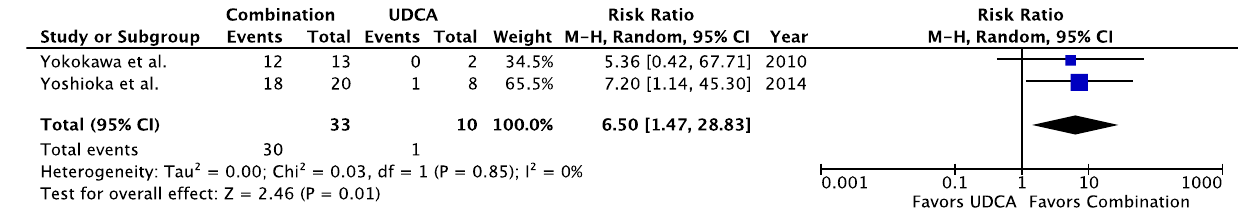
Figure A5. Transplant-free survival in AIH-PBC patients treated with combination therapy vs. UDCA alone, including only those studies in which mean or median follow-up time exceeded 90 months. UDCA = ursodeoxycholic acid, Combination = UDCA + corticosteroids AZA.